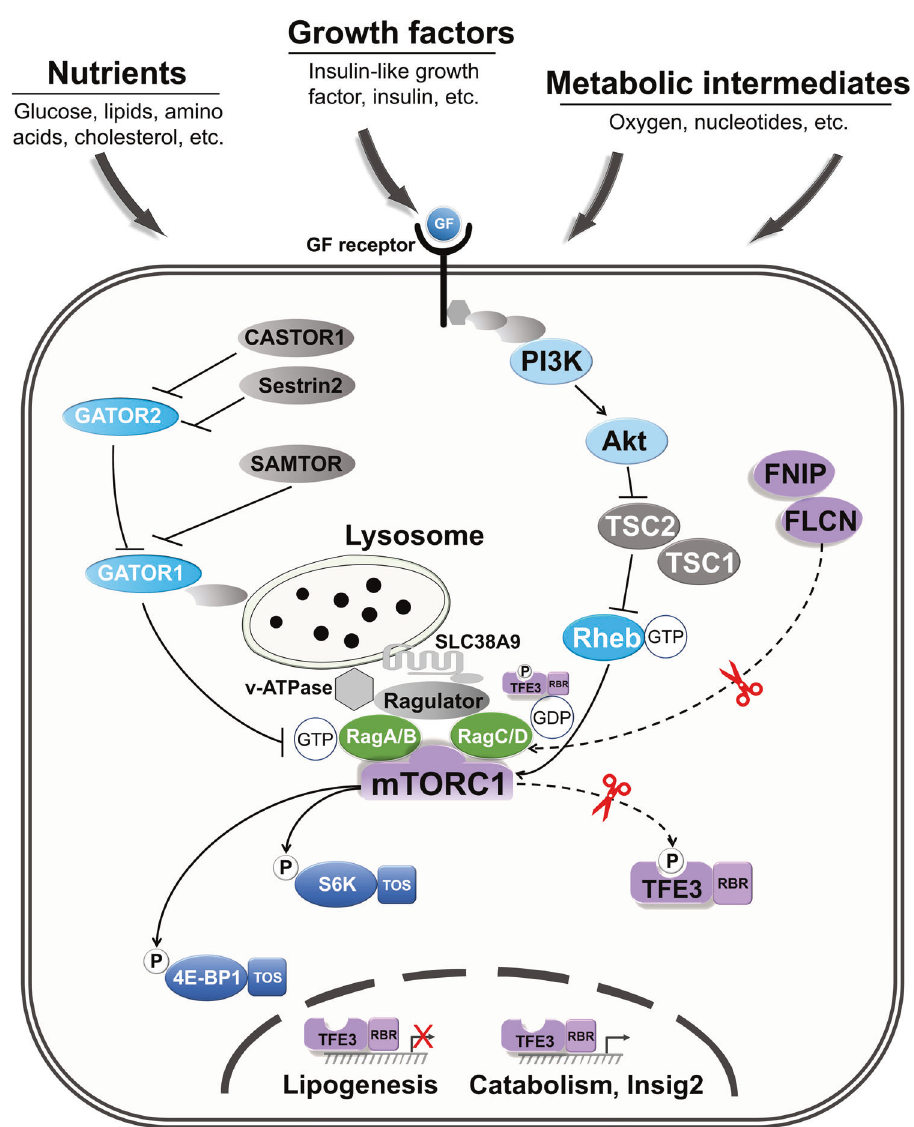
Fig. 1 Canonical and noncanonical mTORC1 signaling based on substrate recruitment and phosphorylation distinctions. mTORC1 is a signaling hub that integrates numerous upstream inputs, including nutrients, growth factors, and metabolic intermediates. Rags is needed for the physical recruitment of mTORC1 to the lysosomal membrane, which is required for mTORC1 activation. The action of mTORC1 on its canonical substrates S6K and 4E-BP1 is regulated by the binding of growth factors and their receptors, which promote the activity of PI3K-Akt- TSC-Rheb signaling axis to activate mTORC1. Instead, the phosphorylation of TFE3 is controlled by FLCN-RagC/D-mTORC1 signaling axis. S6K and 4E-BP1 both have a TOS motif, whereas TFE3 has a Rag-binding region in its structure. This is the mechanism underlying the distinct phosphorylation behaviors of these two mTORC1 substrate classes. GF growth factor, P phosphorylation, GTP guanosine triphosphate, GDP guanosine diphosphate, TOS TOR signaling motif, RBR Rag-binding